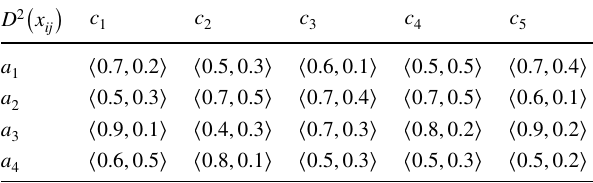
Table 5 Pythagorean fuzzy matrix given by expert 2